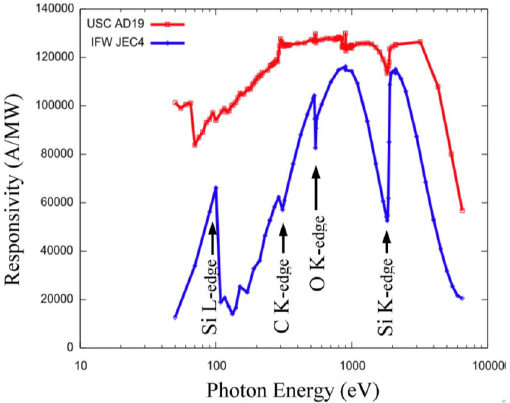
Figure 10. Measured responsivity of a 4H-SiC n-type epitaxial device biased to 250 V and an IFW JEC4 photodiode biased to 120 V.